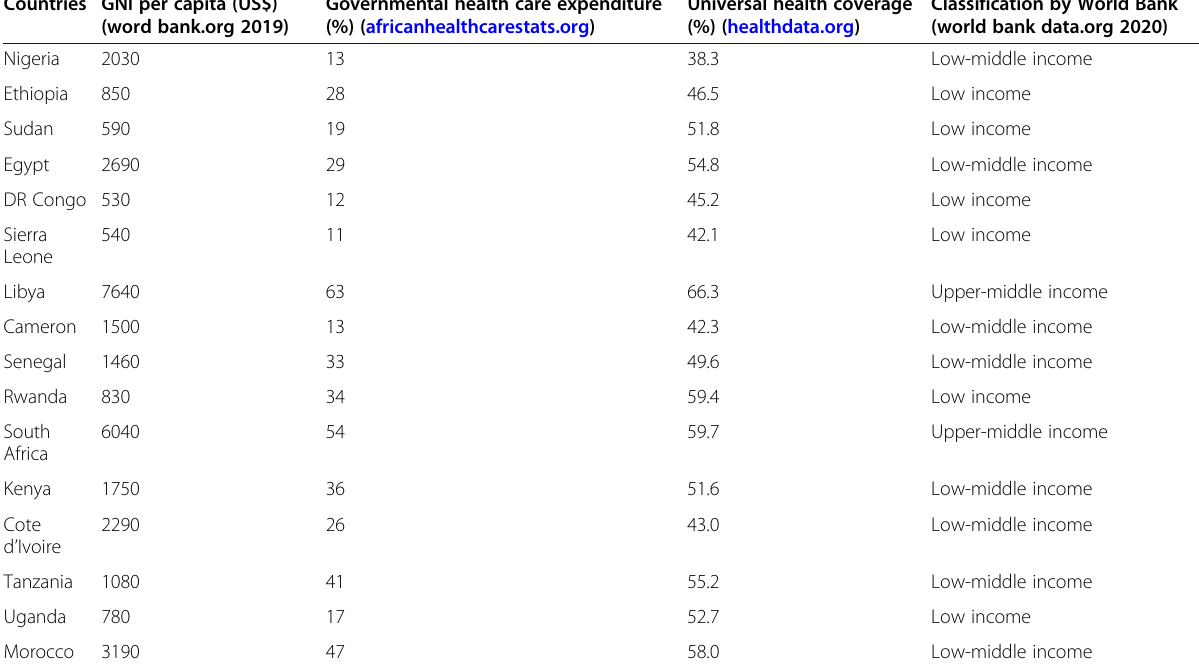
Table 3 Socioeconomic characteristics of African countries included in meta-analysis for prevalence of HBV and HCV in Africa Countries GNI per capita (US$) (word bank.org